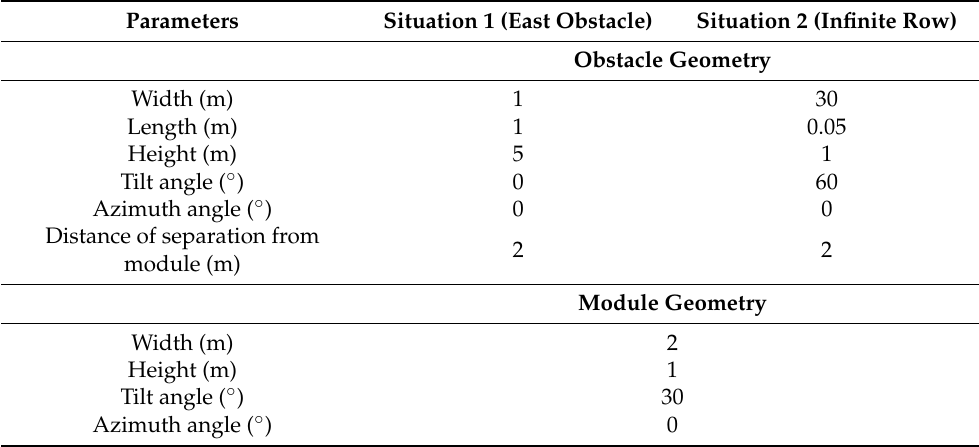
Figure 14. Situation 2, one PV module being shaded by one infinite row in front. The tilt angle of the row is 30 ◦ and is positioned at 2 m from the module. The tilt angle of the module is 30 ◦ and the azimuth angle is 0 ◦ : ( a ) Visual output; ( b ) Heat plot representation of the shading table. Table 2. Geometric parameters of the obstacle and the module for the proposed